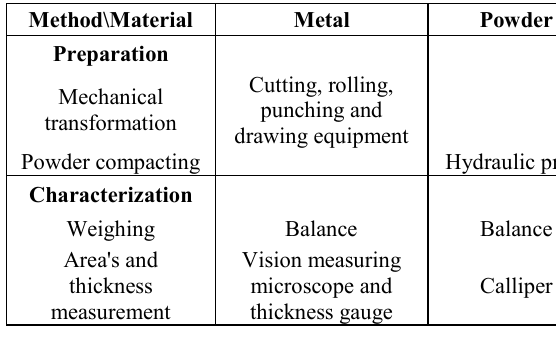
Table 1. Overview of the present preparation and characterization techniques for thick targets.